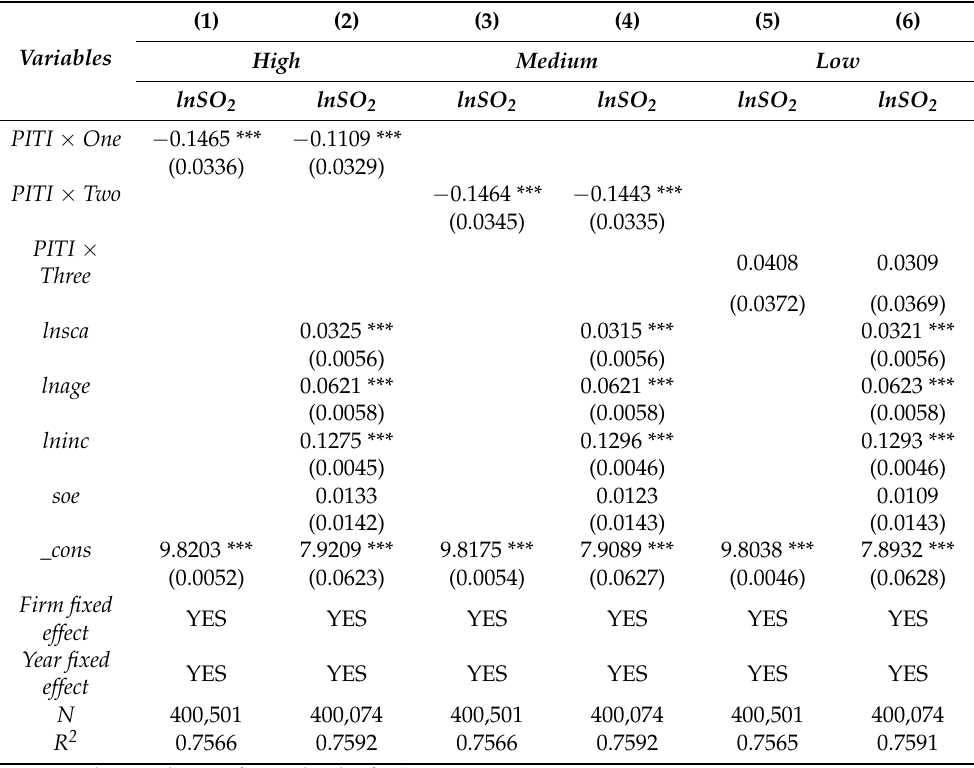
Table 8. The test of regulation intensity